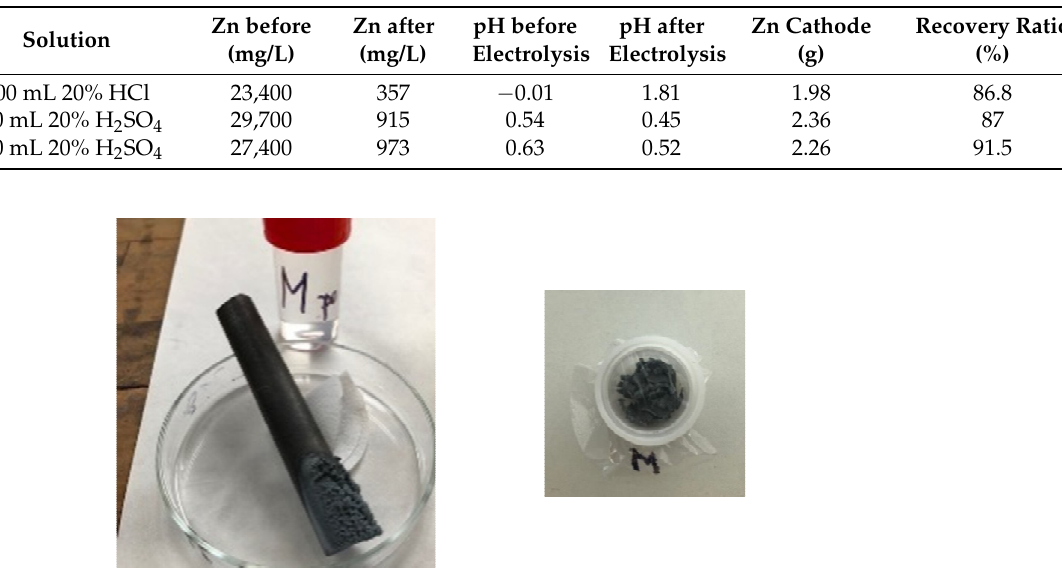
Table 12. AAS analysis results—a condition after dissolving in acids and after the electrolysis.